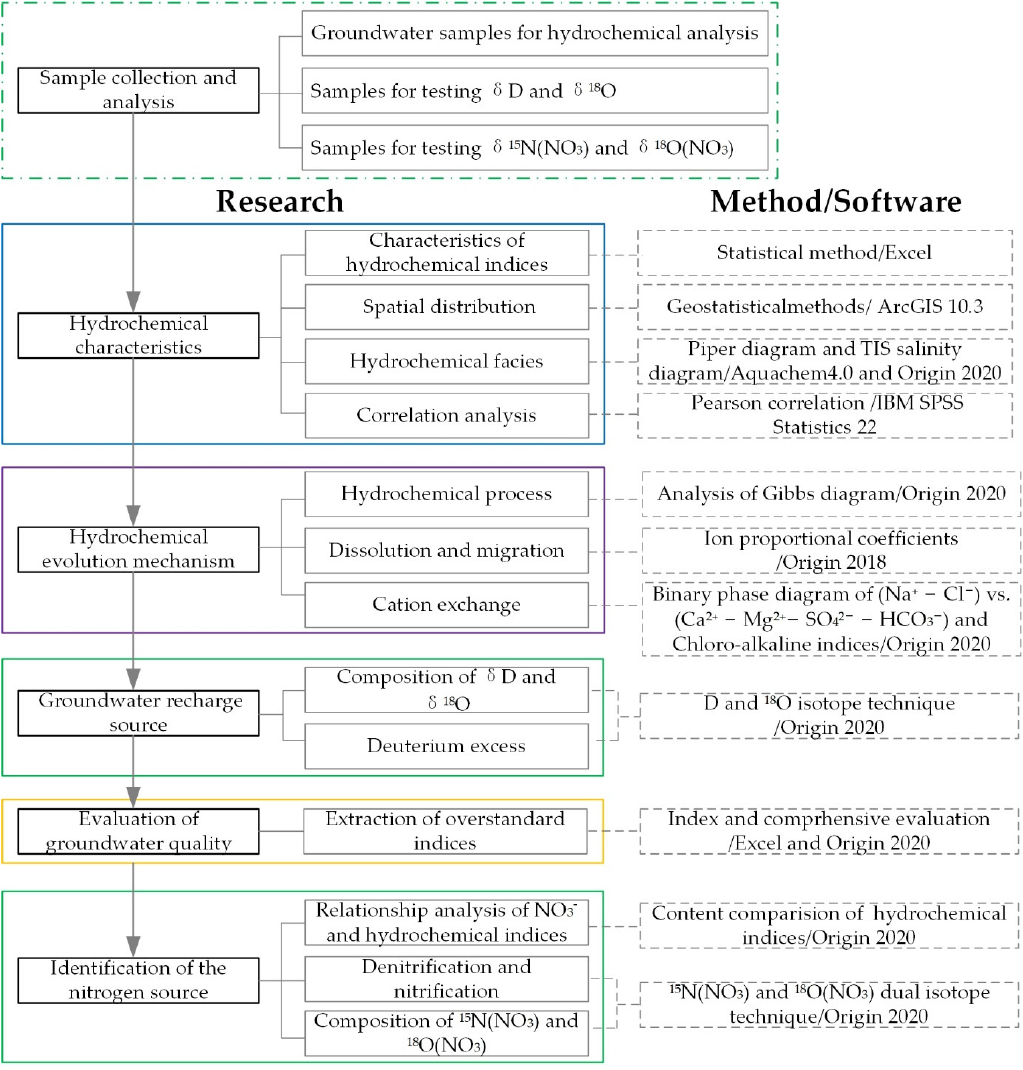
Figure 2. Methodology flowchart. At present, many methods are used to proceed the hydrochemcial research, such as Piper diagram, correlation analysis, Gibbs diagram, ion proportional coefficients, cluster–based methods [14,31–37]. According to previous studies and the study objectives, we used Excel to complete the statistical analysis. Statistics of the minimum, maximum, average and medium were used to reflect the concentration characteristics of the indices. The standard deviation (SD) was applied to reflect the variation degree between the average value and the actual value, and the coefficient of variation ( C v ) was used to indicate the dispersion degree [38]. Based on the geostatistical methods, the spatial distributions of the main hydrochemical indices were obtained by using the Kriging interpolation with the help of ArcGIS 10.3. The Piper diagram drawn by Aquachem 4.0 and the iso–ionic–salinity (TIS) diagram were applied to classify the hydrochemical facies and the salinity distribution. Pearson correlation was undertaken to analyze the relationships among the hydrochemical indices via IBM SPSS Statistics 22. Gibbs diagram, ion proportional coefficients were conducted to reveal the hydrochemical evolution mechanism. Based on the binary phase diagram and chloro – alkaline indices, the cation exchange was judged. Integration of the δ 15 N(NO 3 ) – δ 18 O(NO 3 ) dual isotope technique and hydrochemical analyses was designed to trace the nitrate contamination. Origin 2020 was used to plot Gibbs diagram, TIS diagram, binary phase diagrams, and isotope distribution figures. The details of the methods are listed